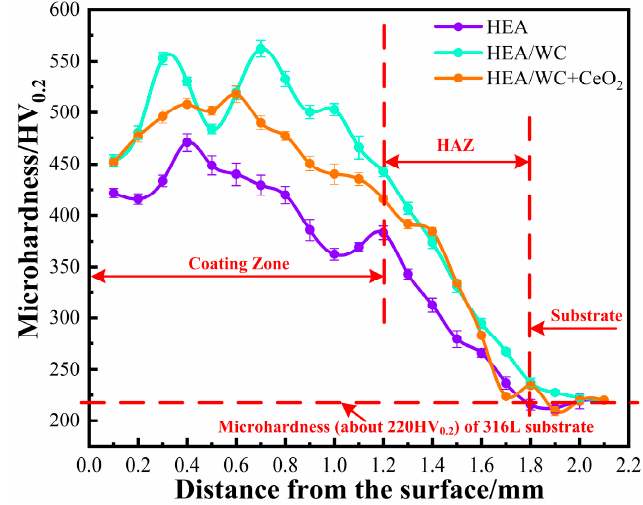
Figure 8. Microhardness distribution curves of different coatings.